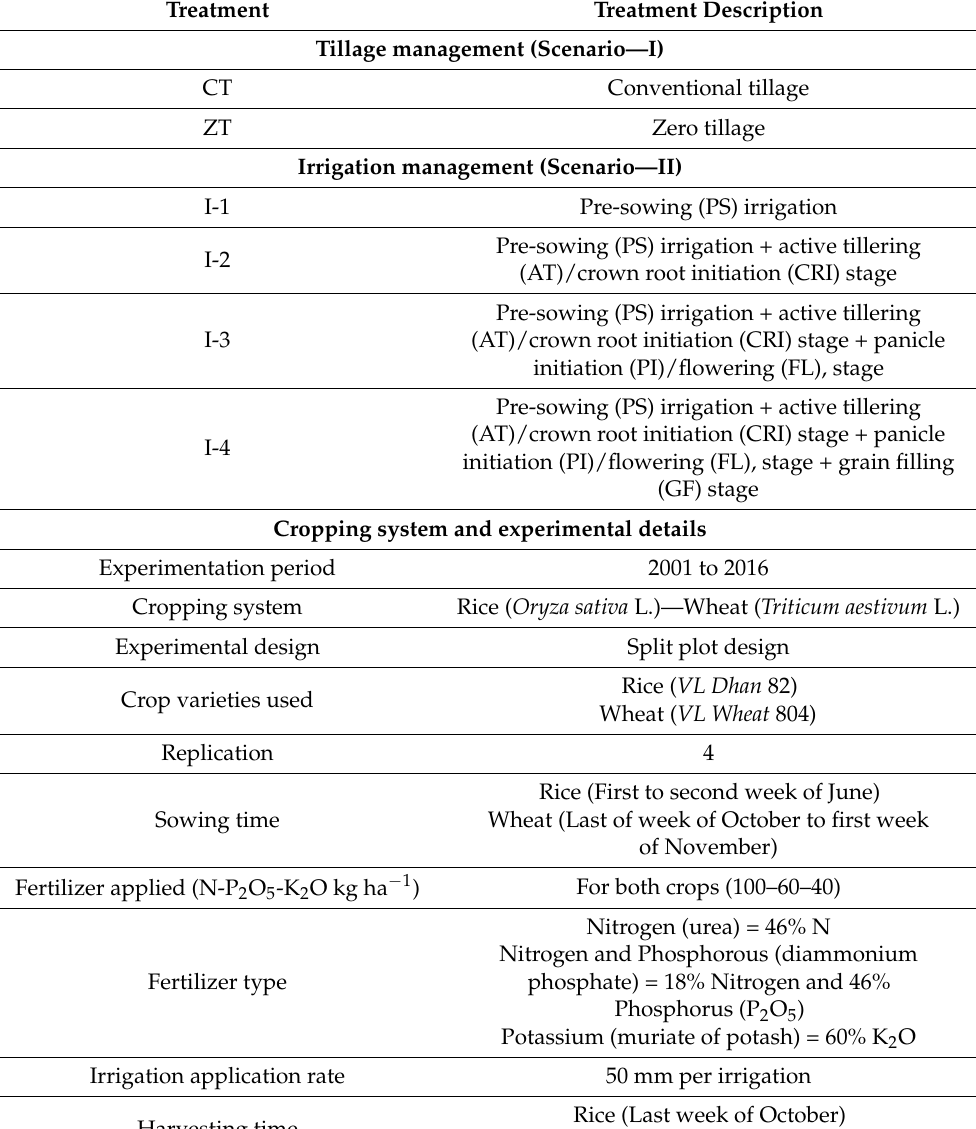
Table 1. Experimental setup and management